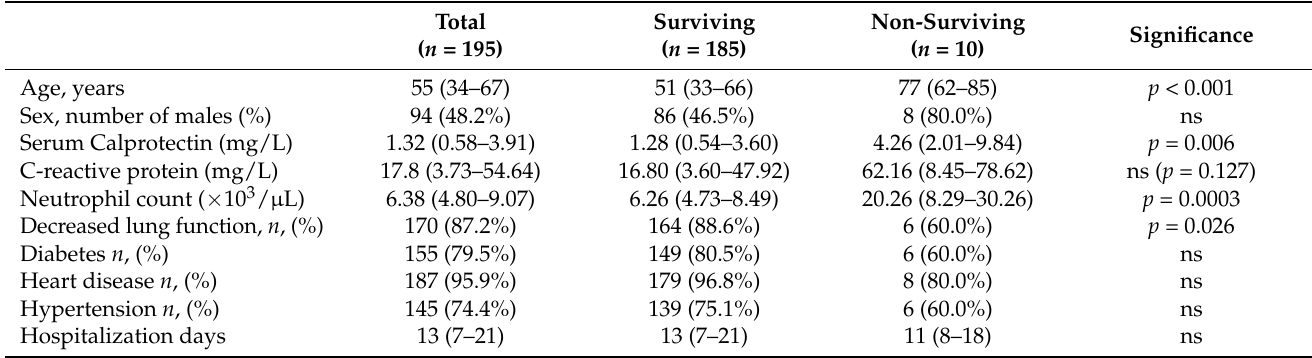
Table 1. Demographic and biochemical inflammatory parameters of studied